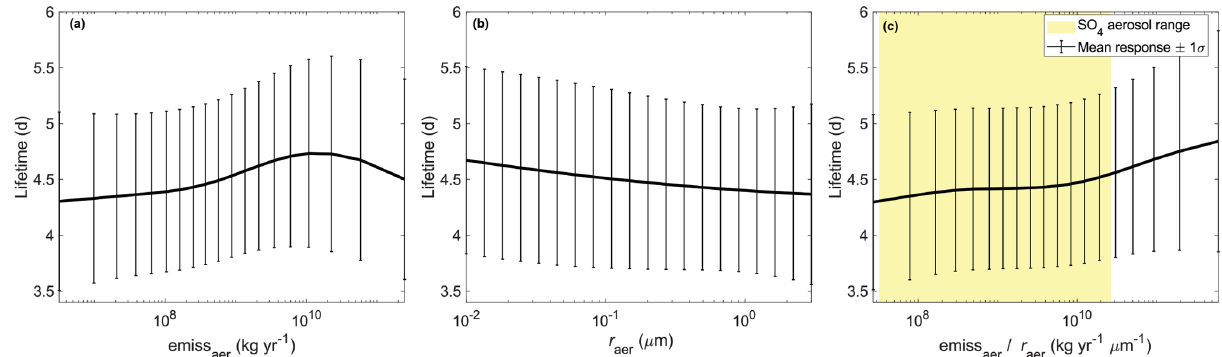
Figure 7. Relationship between the atmospheric Se lifetime and the dummy aerosol input parameters (a, b) . A quantity related to surface area is shown in (c) , which also includes the comparable range for sulfate aerosol as yellow shading. For sulfate, this is calculated by dividing the deposited mass of sulfate (equal to emitted mass in steady state) in each 10 ◦ latitudinal band by the effective sulfate radius in that latitudinal band. Since aerosol mass emissions are a lognormally distributed quantity, the bounds are infinite and thus we include only the 5th to 95th percentile range in (a, c)